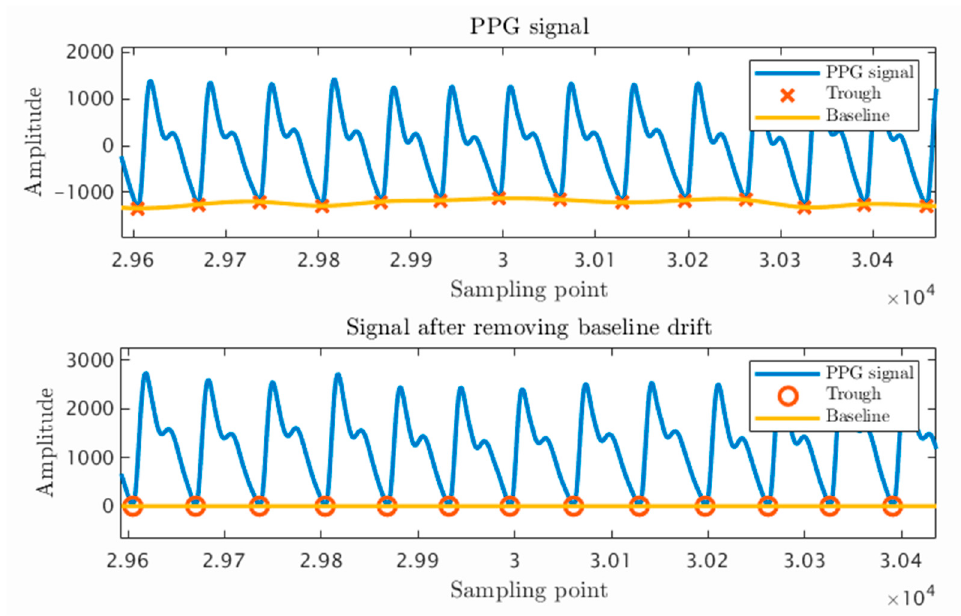
Figure 6. Cubic spline di ff erence removes the baseline deviation of the PPG trough.